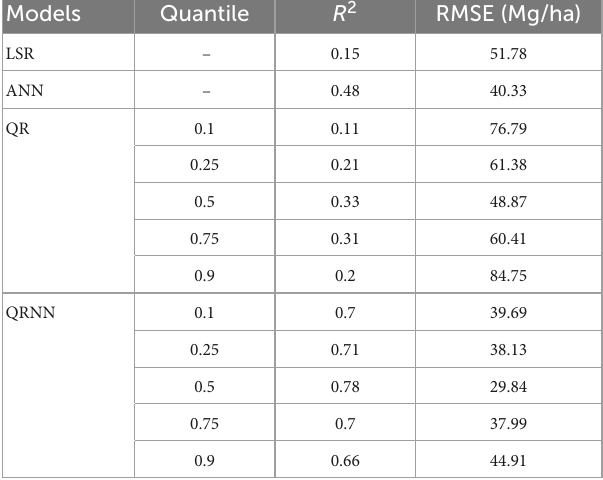
TABLE 4 The evaluation results of four models ( n = 73).